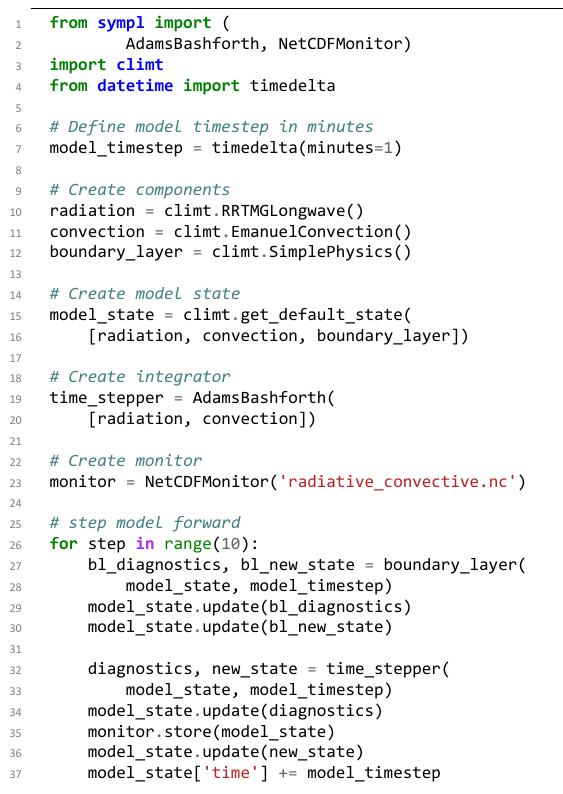
Figure 2. A Python script which calculates the radiative–convective equilibrium temperature of an atmospheric column for a fixed sur- face temperature. See the text for a detailed description.